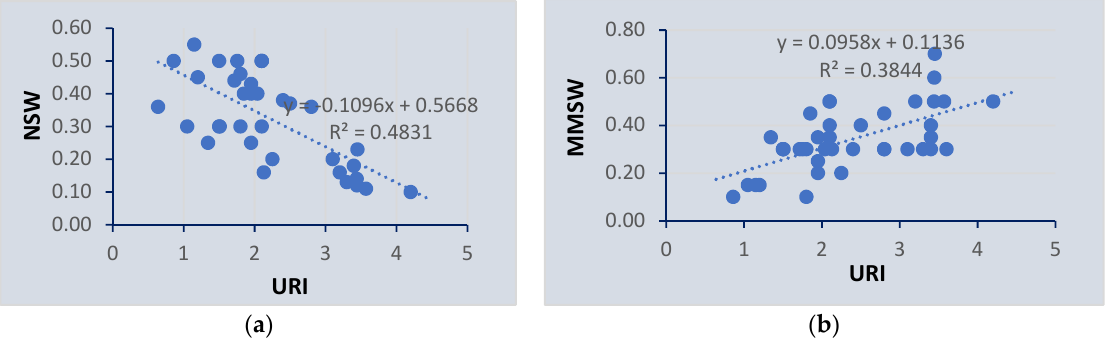
Figure 7. Correlation of urbanization with natural clogging factors ( a ) and man-made clogging factors ( b ). For urban catchments, the channel slopes of cross-drainage and other catchment topographic indices have no significant impact on the failure of cross-drainage structures as a result of debris and other solid wastes, as shown in Figure 8